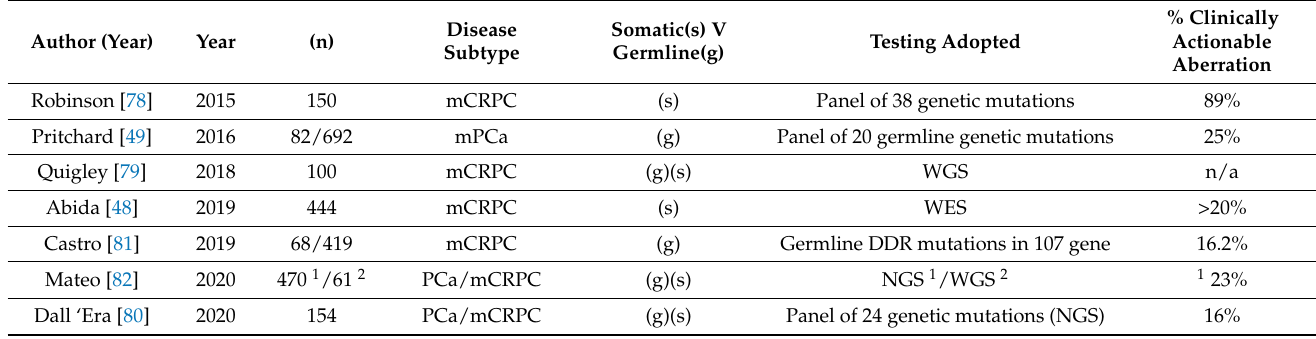
Table 4. Studies assessing the genomic landscape of